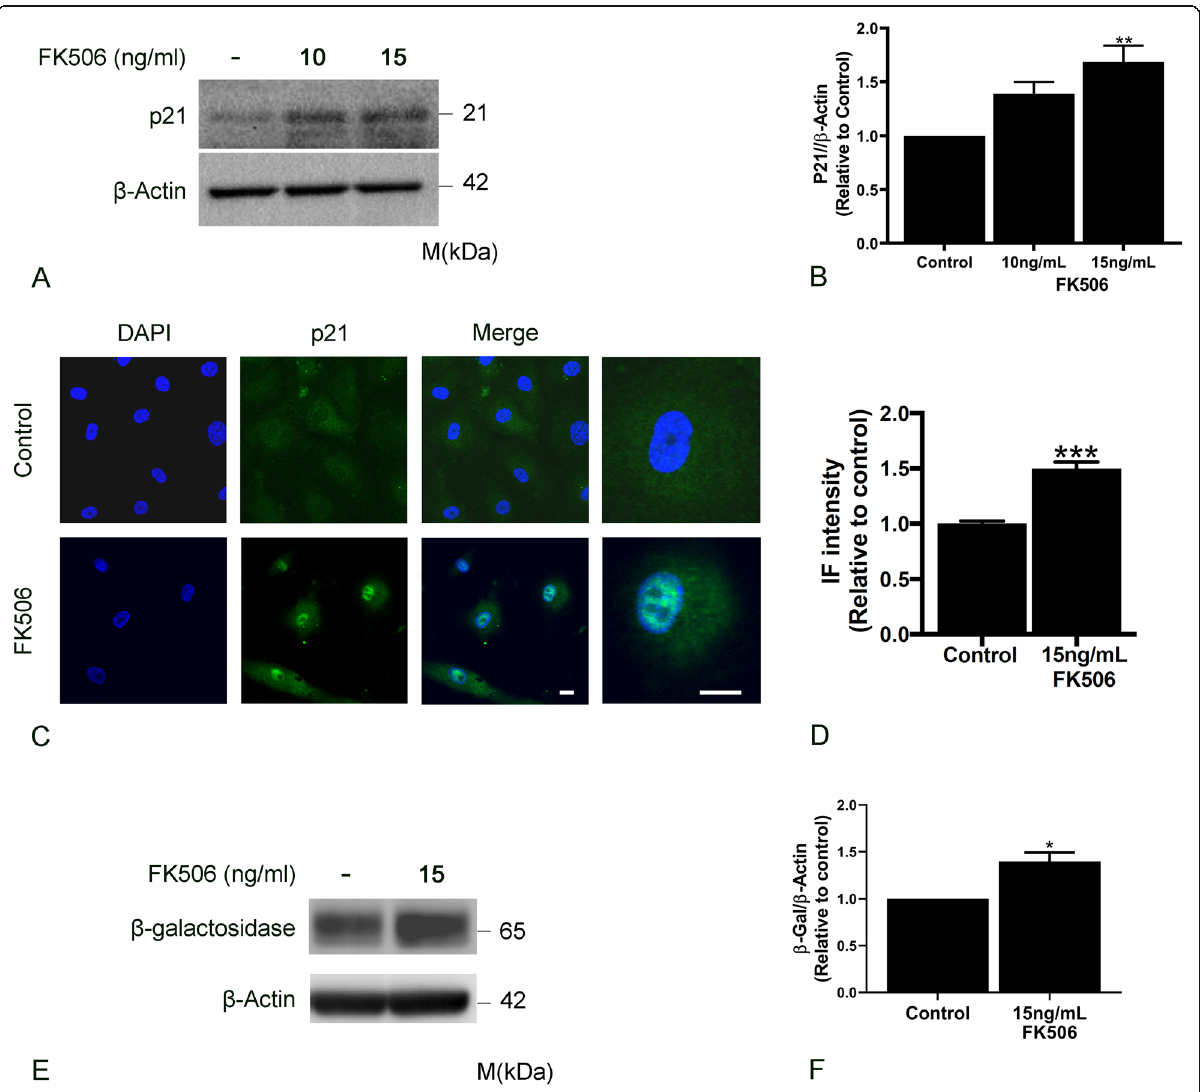
Fig. 2 FK506 induces Lymphatic endothelial cell senescence. Lung lymphatic endothelial cells were treated with FK506 (15 ng/ml) for 72 h. Whole cell lysates were analyzed by Western blotting with antibodies against p21( a ) and β -galactosidase ( e ). Ratio of p21 ( b ) and β -galactosidase ( f ) to β -actin density was expressed as fold-change relative to control. Data represent mean ± SEM of three independent experiments (one technical replicate each) * p < 0.05 by one-way ANOVA. Representative images of immunofluorescent staining of single and merged images of p21 (green) and 4 ′ ,6-diamidino-2-phenulindole (DAPI; blue) at low and high magnification (far right panel) with and without treatment with FK506 (15 ng/ml) for 72 h ( c ). Random images (9 – 12 images) were obtained and nuclear intensity of p21 staining was measured using Image J software ( d ). Data represent mean ± SEM of one experiment (** p < 0.01). Results were reproduced in 3 independent experiments (Size bar: 40 μ